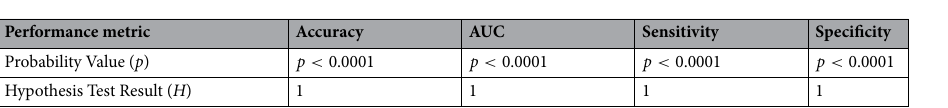
Performance metric Accuracy AUC Sensitivity Specificity Probability Value ( p ) p < 0.0001 p < 0.0001 p < 0.0001 p < 0.0001 Hypothesis Test Result ( H ) 1 1 1 Table 2. Results from the paired-sample t test. The significance level ( α ) is set at α = 0.001 .